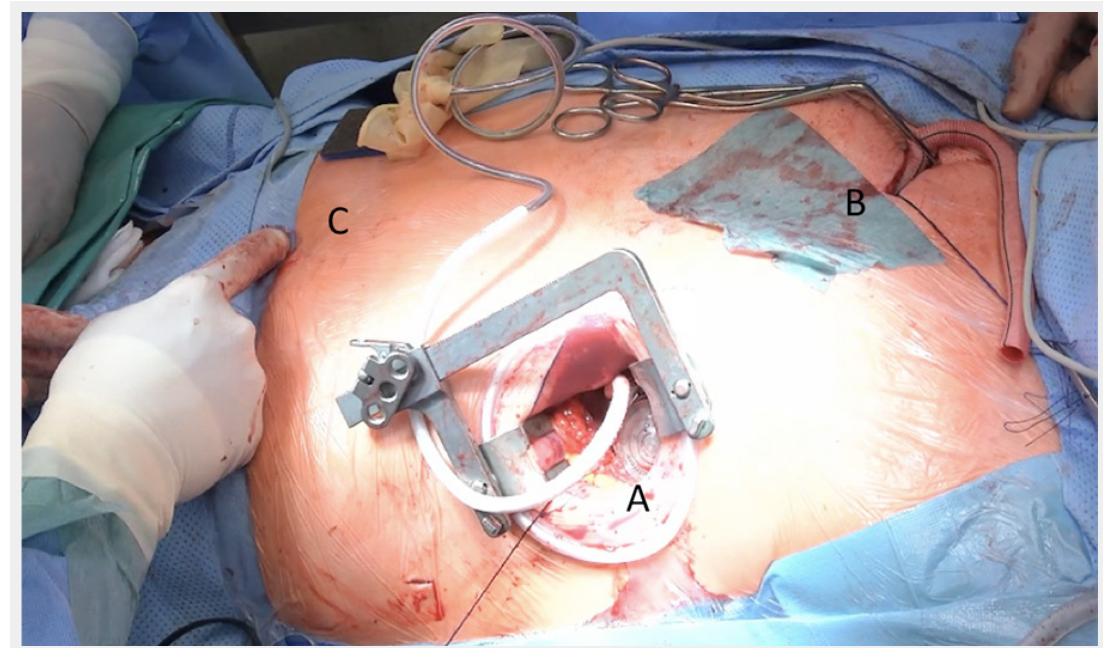
Figure 3 Surgical technique: the minimal invasive approach. Patient’s head is on the right hand side. Left anterior thoracothomy to expose cardiac apex and insert the inflow cannula (A), the mini right anterior thoracotomy to expose the ascending aorta to suture the outflow graft (B) and the point where the driveline pierces the skin (C).